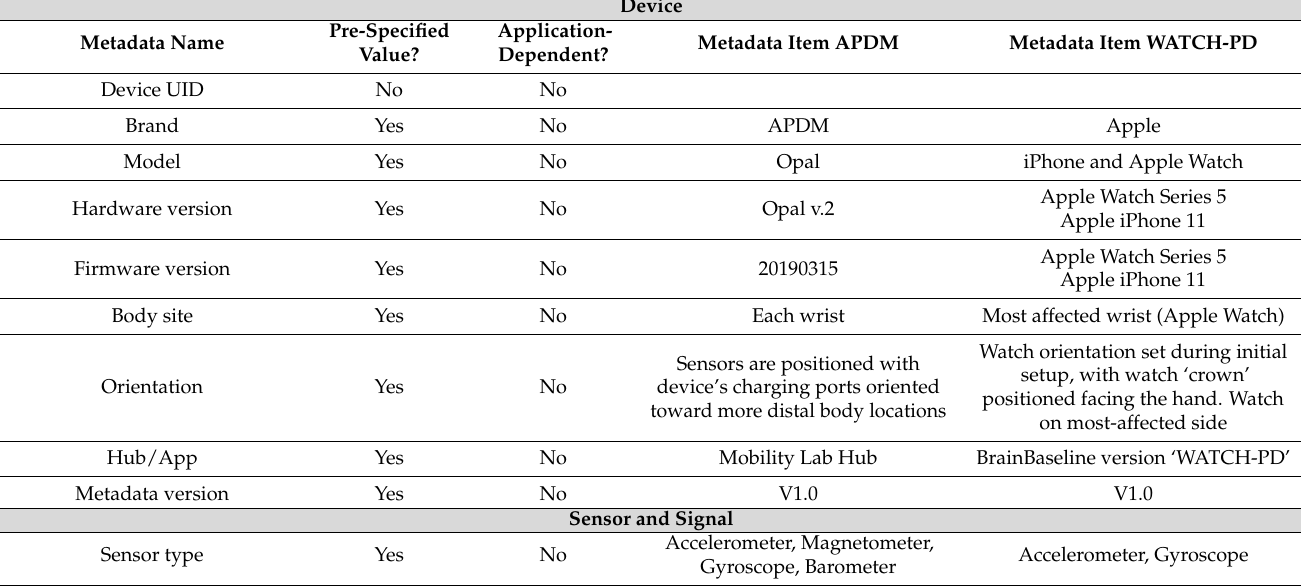
Table 1. Table of metadata concepts for WATCH-PD.